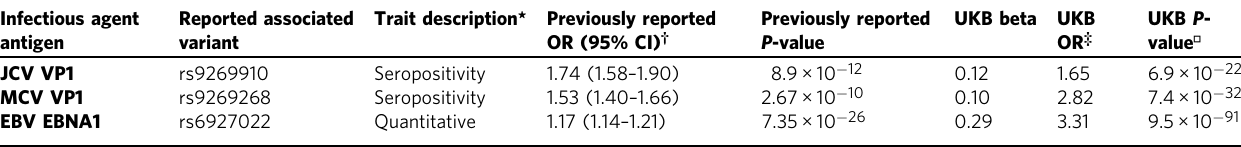
Table 4 Replication of genetic variants previously associated with exposure to speci fi c infectious agent antigens. Infectious agent Reported associated Trait description* Previously reported antigen variant OR (95% CI) †